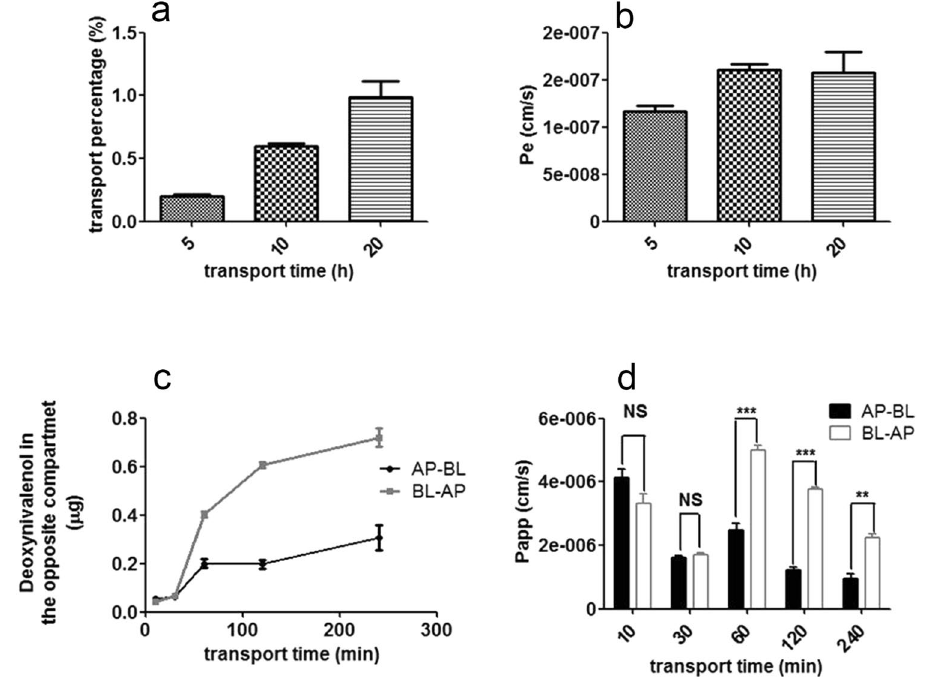
Figure 2. Analysis of the mechanisms of DON transport using the PAMPA and Transwell models. ( a ) The percentage of DON in the acceptor well of the PAMPA assay after 5, 10 and 20 h incubations with 10 μ g/ml DON at 25 °C. ( b ) Permeability (Pe) (cm/s) observed after 5, 10 and 20 h. ( c ) Kinetics of the transepithelial flux of 10 μ g/ml DON through a monolayer of MDCK cells in the Transwell model in the AP-BL and BL-AP directions. The data are presented as the mean values ± SD (n = 3). ( d ) Apparent permeability coefficients (P app ) of DON in the Transwell model. Student’s t-test was used to analyze differences, and statistically significant differences in these values between the AP direction and the BL direction are indicated. ** P < 0.01, *** P < 0.001. Abbreviations: AP, apical; BL, basolateral; NS, no significant